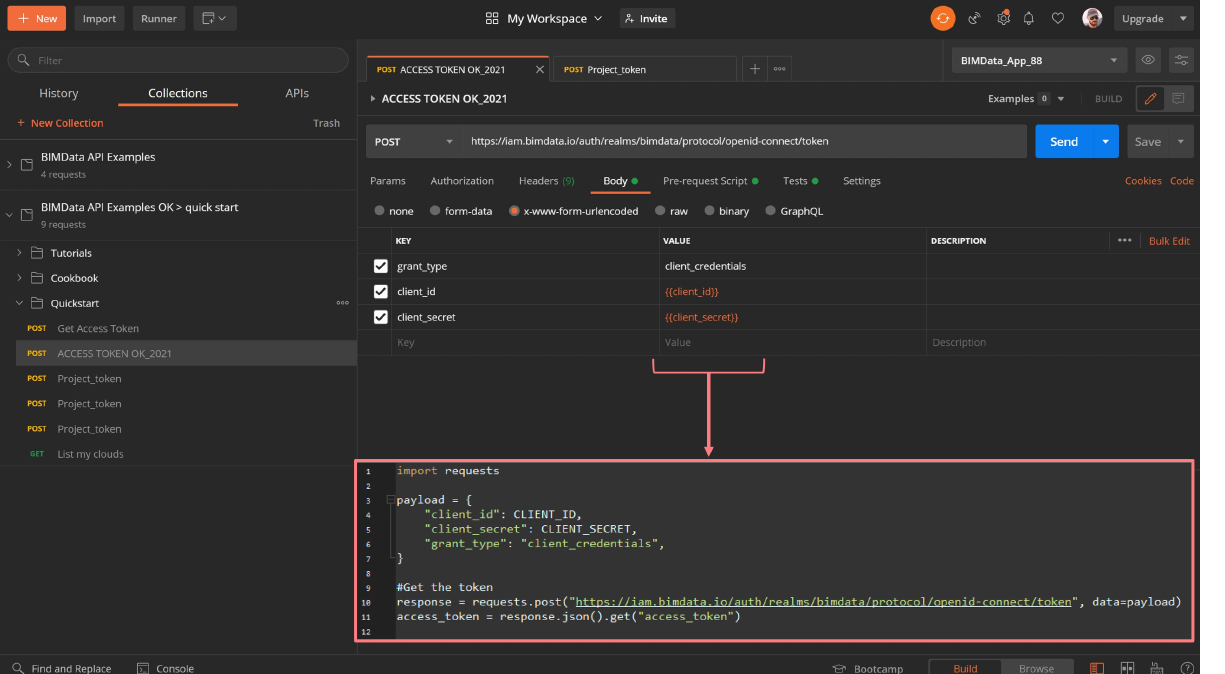
Figure 5. Access Token evocation via Postman (by form encoded and raw Python coding).